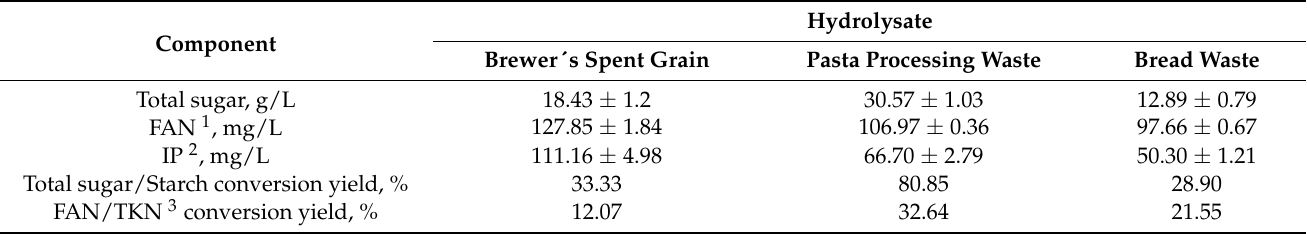
Table 3. Agro-food byproducts hydrolysates composition.